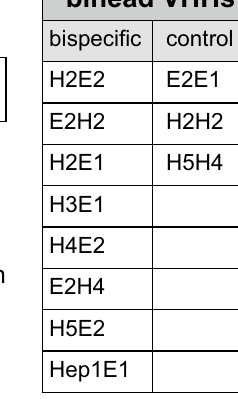
Table 1. VHH llama antibodies combined in bispecific VHHs with a sequence of [G 4 S] 2 in between the VHHs. H is anti-HIV-1, E is anti-EGFR and Hep is anti-hepatitis B VHH. Bispecific VHHs were generated in various combinations. E.g. H2E2 denotes a bispecific VHH antibody with N-terminal VHH 1F10 linked to C-terminal EGb4. E1 (EgA1) is an antagonistic anti-EGFR VHH that blocks EGF binding, whereas E2 (EgB4) is a non-antagonistic antibody that binds to Domain I of EGFR 41 . The anti-HIV antibodies H2 and H3 were raised against gp120 envelope protein 35 , H4 against gp41 40 and H5 against gp140 protein 37 . Hep1 binds the hepatitis B virus (HBV) surface antigen (HBs) 46 . This HBs is expressed in HBV virus like particles (ADW & ADY). Bispecific VHHs generated in this study are H2E2, E2H2, H2E1, H3E1, H4E2, E2H4, H5E2, Hep1E1 and control biheads E2E1, H2H2,